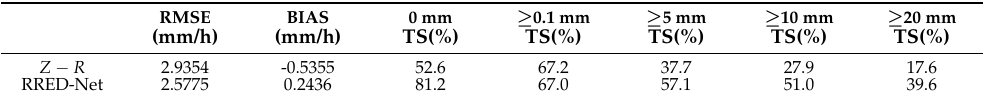
Table 8. Comparison of Z − R relationship based traditional method and our RRED-Net. RMSE BIAS 0 mm ≥ 0.1